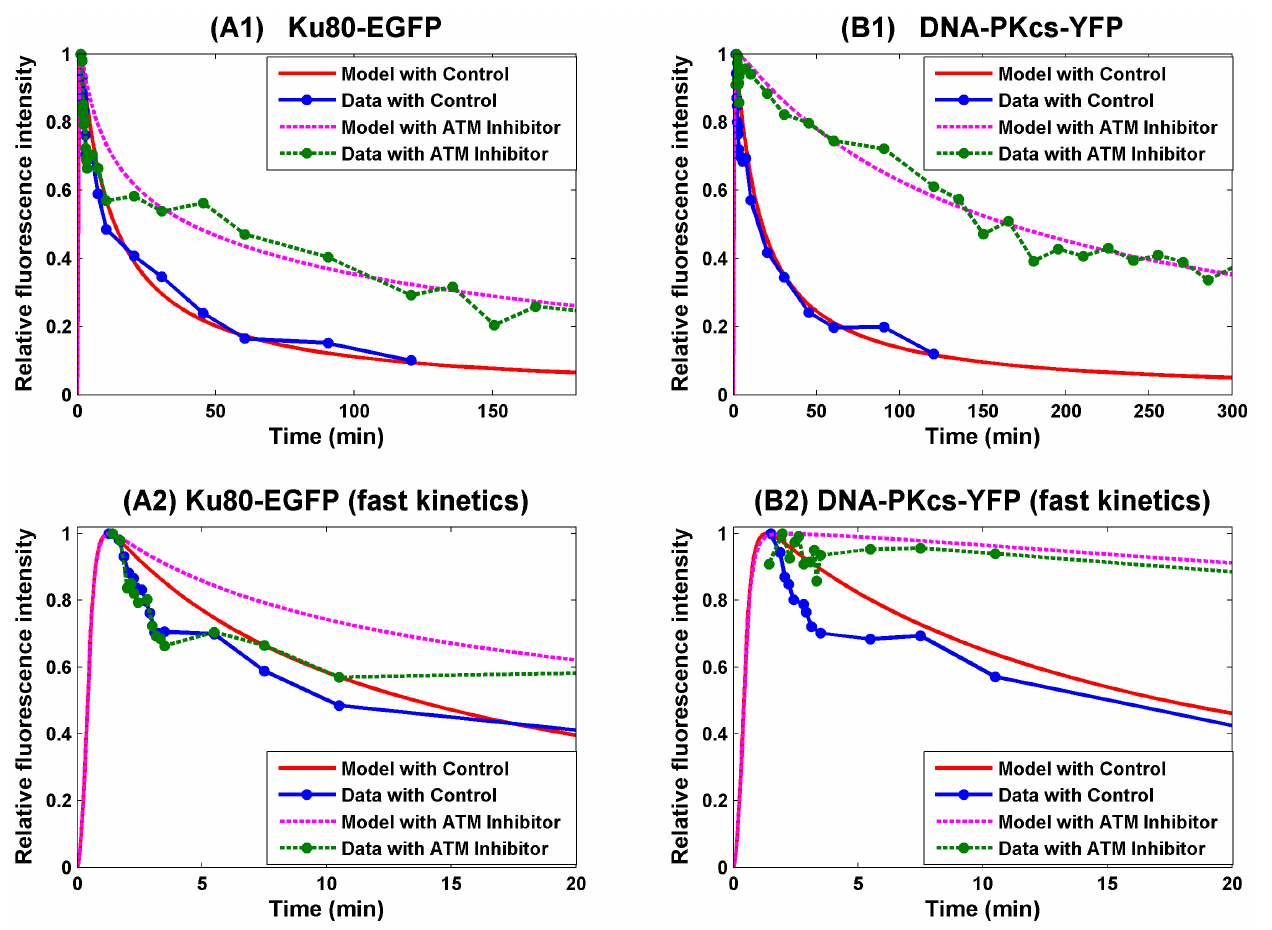
Figure 5. SF Model - Formation and loss of Ku80-EGFP and DNA-PKcs-YFP at the DSB in the radiation stripes with merged synapsis formation and ends processing. Panel (A) is for Ku80-EGFP and panel (B) for DNA-PKcs-YFP. The first row is for the overall kinetics and the second row is for the fast kinetics. The lines with dots are experimental data from [1], and those without dots are numerical simulation of the model. The solid lines are represent calculated normalized fluorescence intensity of the respective fluorescently tagged proteins with control, and the dashed lines are with ATM inhibitor applied.